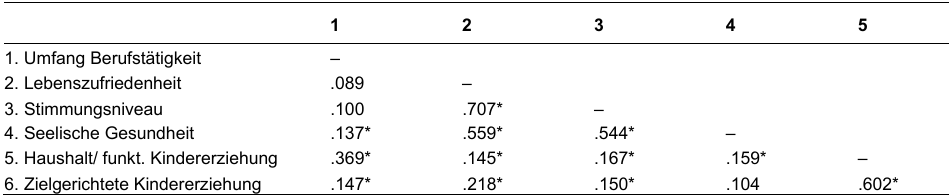
Tabelle 3 : Produkt-Moment-Korrelationen zwischen Umfang der Berufstätigkeit und Wohlbefinden der Mutter sowie Aufgabenübernahme des